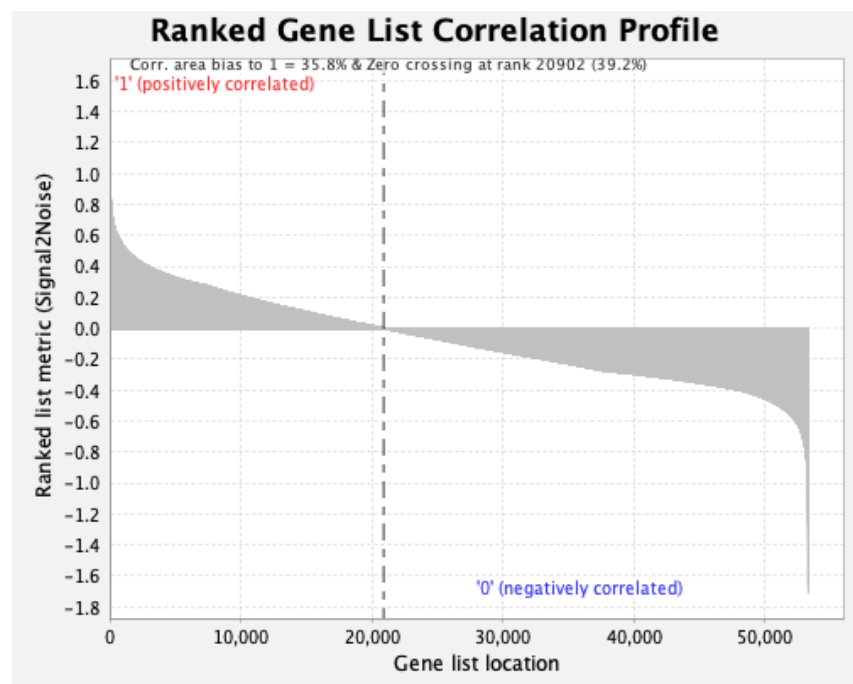
Figure 10. Plot showing correlation between ranked gene list and toothpaste treatment where ‘1’ represents SnF 2 and ‘0’ represents sodium monofluorophosphate (MFP). Out of the 53,290 total genes, 20,902 correlated with SnF 2 while 32,388 correlated with MFP.